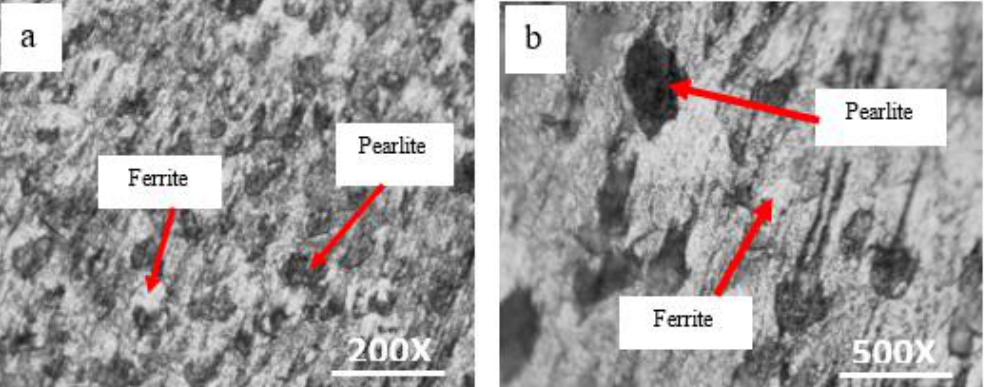
Figure 5: Optical micrograph of low carbon steel at (a) lower and (b) higher magnification for the base metal before